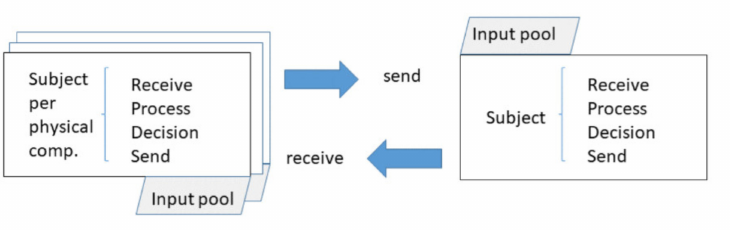
Figure 7. CPS components as subject representations used for digital twin representation—each physical and digital component becomes a subject.